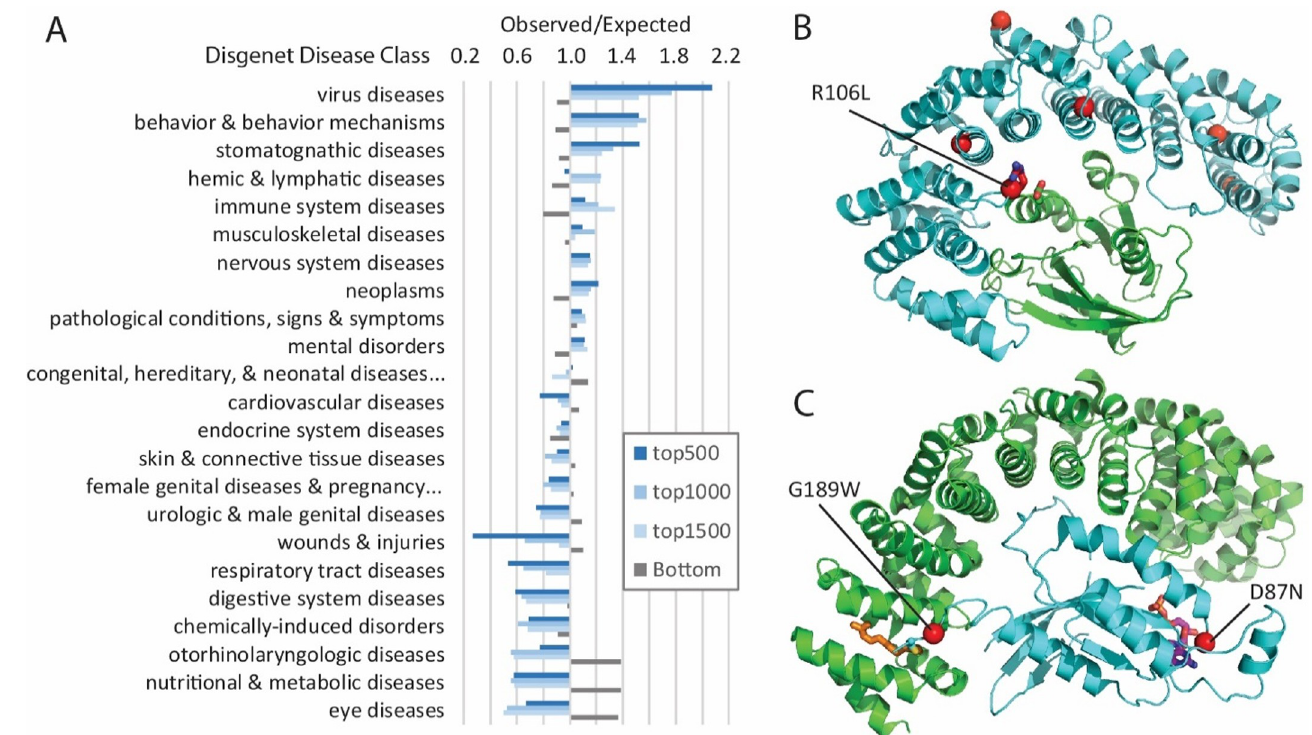
Fig 7. Mutation-intolerant genes exhibit pathway preferences and are exploited by viruses. A) Genes are ranked from low to high by mutation severity measure, GTS. The top ranked genes are mutation-intolerant, and the bottom ranked are mutation-tolerant. Ratios of observed/expected frequencies of disease class associations for sets of mutation-intolerant (top-) and mutation-tolerant (Bottom) genes are shown. Diseases are ordered by the exp/obs frequency ratios in the top1000 set (top 1000 genes with the lowest GTS score). B) Ribbon diagram of KPNB1 (cyan) bound to Ran GTPase (green) with DeepSAV-predicted detrimental variants (red spheres), including R106L (stick) at the interaction interface (from PDB 1ibr). C) Ribbon diagram of GEF (green) bound to RHOA GTPase (cyan, PDB 5zhx), with labeled DeepSAV-predicted detrimental variants (red spheres) adjacent to a farnesylation site (orange stick) and near the active site (stick colored by atom, from superimposed GTPase